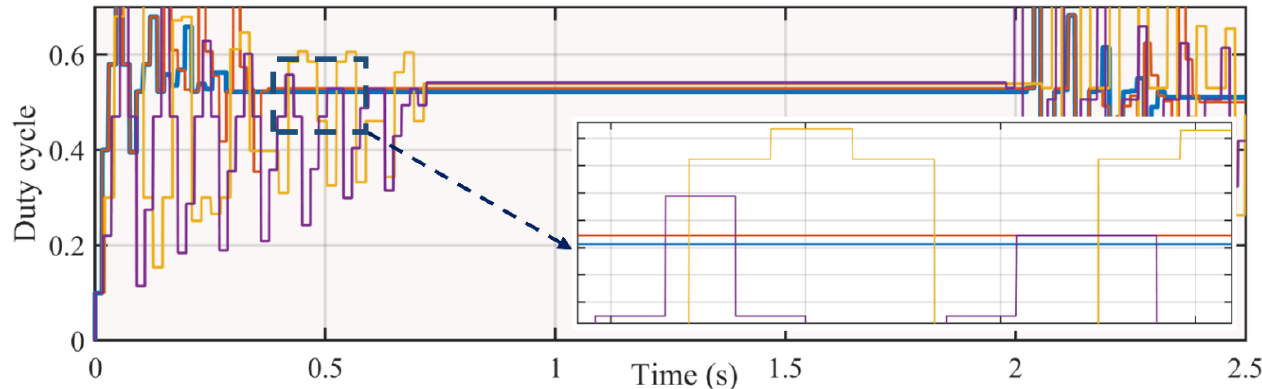
Figure 19. Competing techniques zoomed-in duty cycle Case-2.